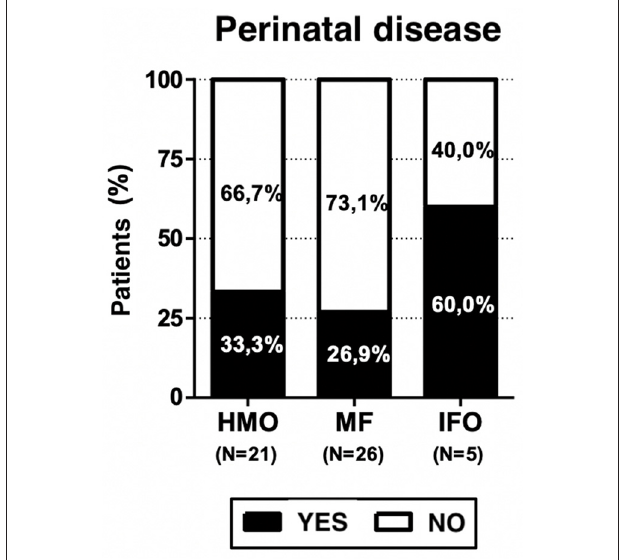
FIGURE 4 | Prevalence of perinatal disease among the study population.